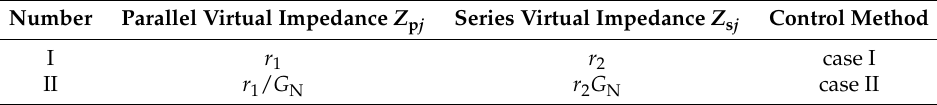
Table 1. Different conditions of adding parallel-series virtual impedances.